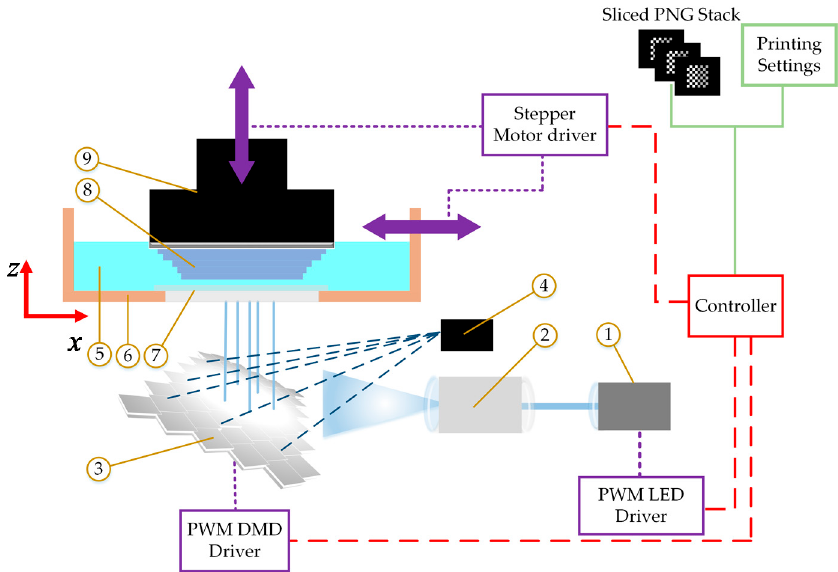
Figure 1. Schematic of a typical projection-based stereolithography additive manufacturing system (PµSLA).